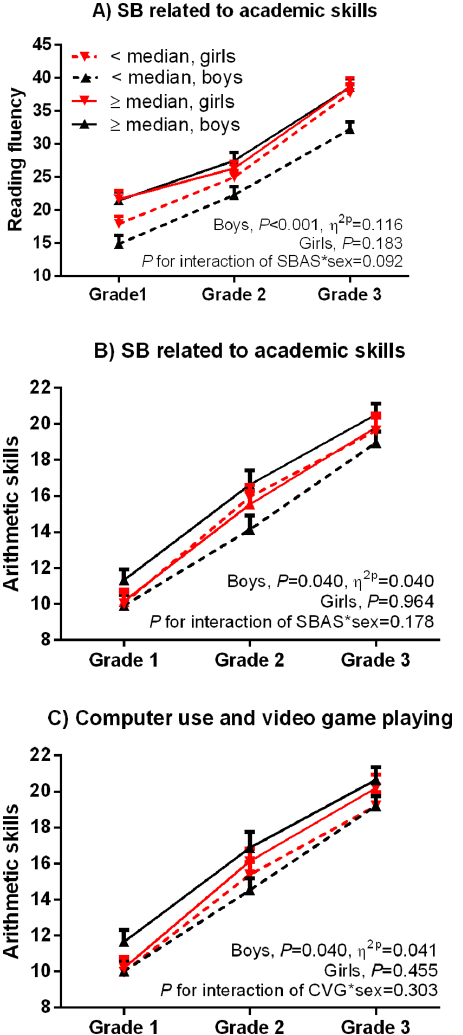
Figure 2. Differences in academic skills in Grades 1–3 between children who were in the upper and lower halves of sedentary behavior related to academic skills (A and B) and computer use and video game playing (C) in Grade 1 among 107 boys and 79 girls. Data are from analyses of covariance with repeated measures adjusted for age, parental education and the PANIC study group (intervention vs. control). SB=Sedentary behavior; CVG=Computer use and video game playing; SBAS= Sedentary behavior related to academic skills. Error bars represent standard errors of the mean (SEM).